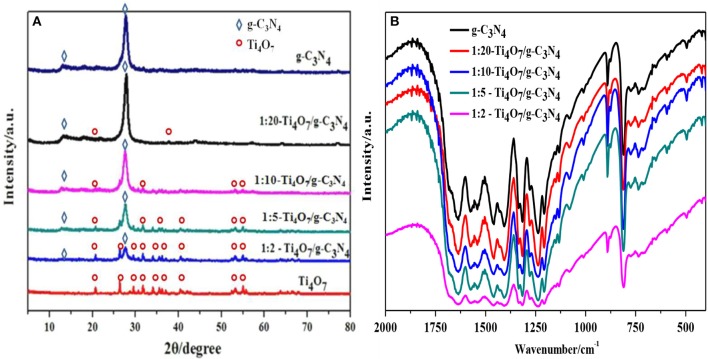
Structure and morphology analysis of g-C3N4 and Ti4O7/g-C3N4 photocatalysts: (A) XRD patterns analysis; (B) FTIR spectrometer analysis.